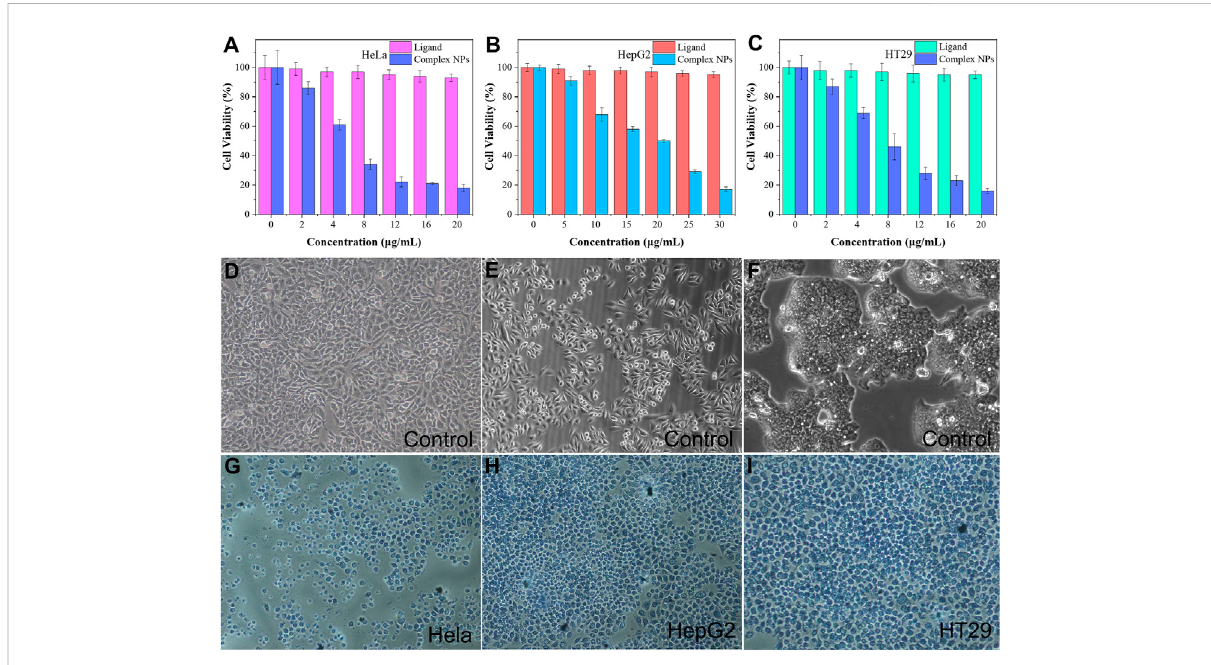
FIGURE 6 (A – C) In vitro MTT assay of HeLa, HepG2, and HT29 cells was treated with ligand H4L and complex NPs; trypan blue fl uorescent staining of the control group for (D) HeLa cells, (E) HepG2 cells, and (F) HT29 cells; Complex NPs for (G) HeLa cells (H) HepG2 cells (I) HT29